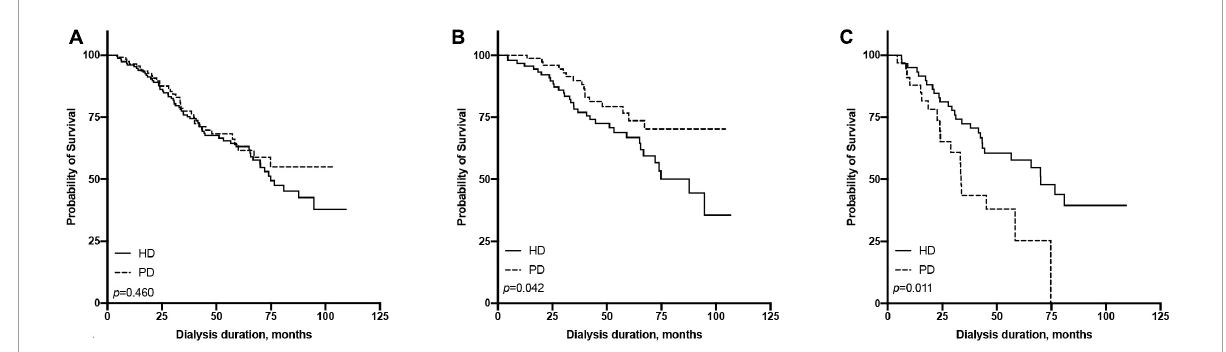
to eliminate the differences in baseline characteristics, HD was still a protective factor for multivariate Cox regression ( Table 4 ).